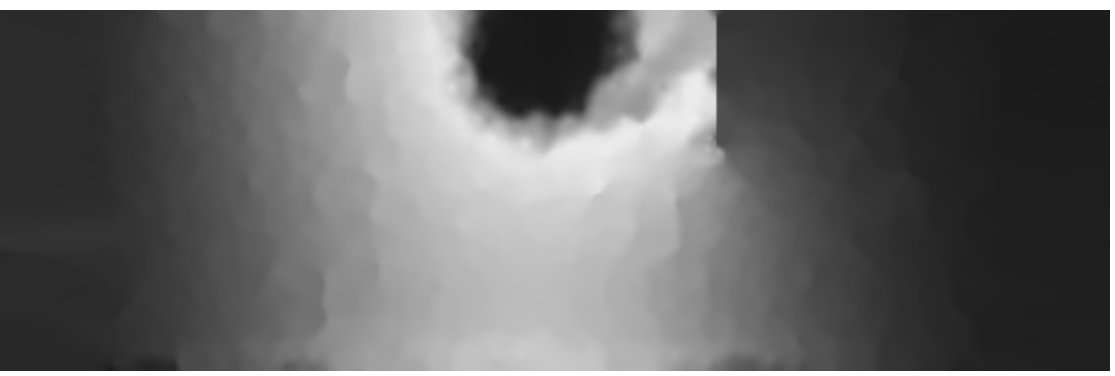
Figure 15. Heat map generated by run (2) .